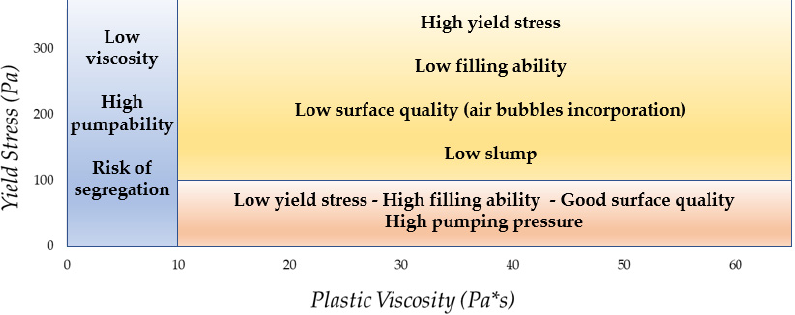
Figure 8. Summary of the impact of rheological parameters on concrete performance (adapted from [33]).